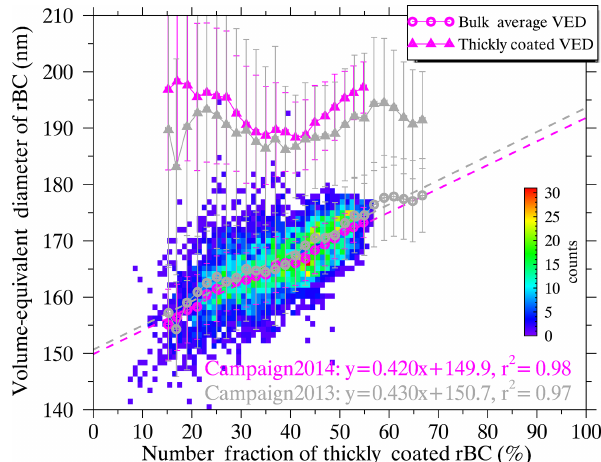
Figure 4. Two-dimensional histogram of the 5min average volume- equivalent diameter of rBC (VED rBC ) against number fraction of thickly coated rBC (NF coated ) during the campaign in the late win- ter in 2014. The magenta circles and triangles with error bars repre- sent the mean VED rBC and VED of thickly coated rBC (VED coated ) averaged in each NF coated bin with a resolution of 2%, respectively. The dashed magenta line denotes the linear regression of VED rBC against NF coated . The relationship between VED rBC and NF coated during another campaign in January 2013 (Wu et al., 2016) is com- paratively overlapped in